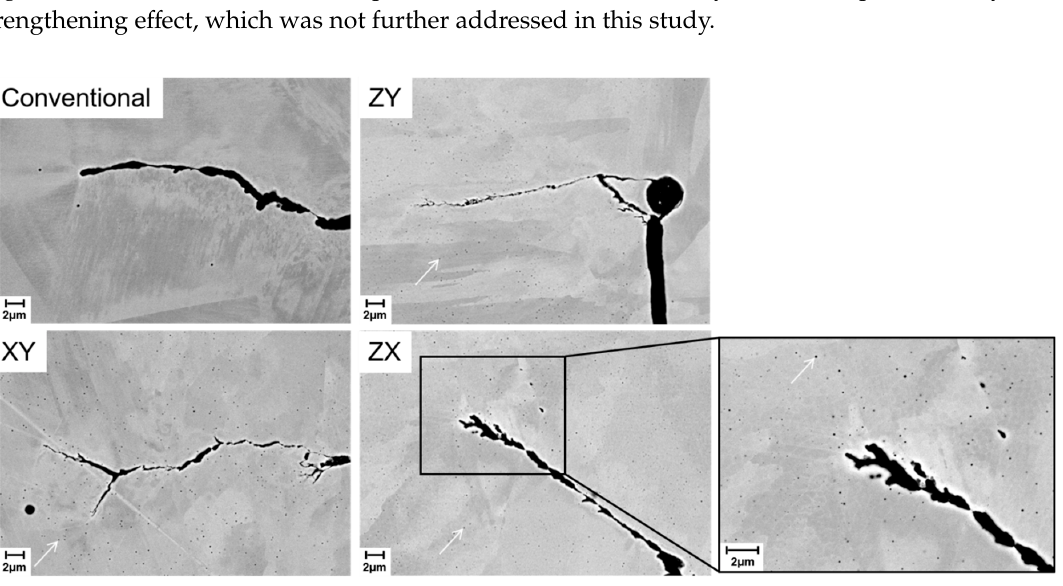
Figure 15. Crack length based on number of loading cycles of additively manufactured material with regard to build direction.